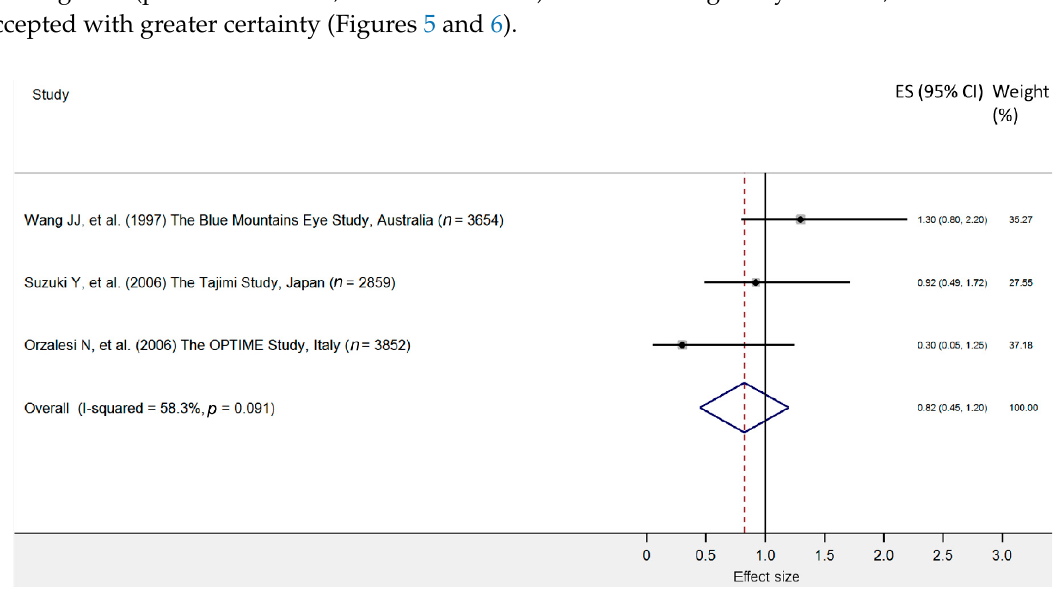
Figure 5. Forest plot of cohort studies that evaluated migraine as a risk factor for primary open angle glaucoma. The effect size (square, with size proportional to weights used) and 95% confidence intervals (horizontal lines) is presented for each study. The overall measure revealed by pooled analysis is marked with the center of the diamond, while the associated confidence intervals are marked by the lateral tips of the diamond [11,31,49].